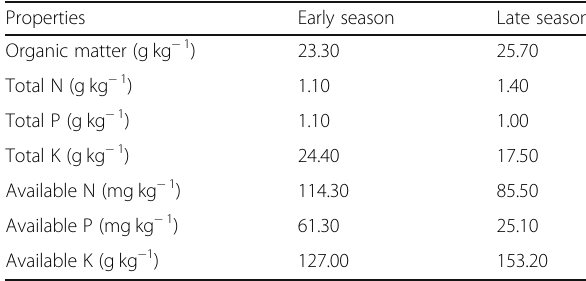
Table 2 Properties of the experimental field soil